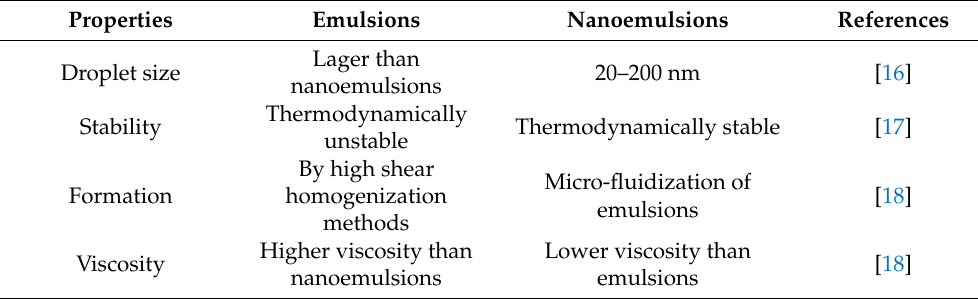
Figure 3. Stabilization of emulsion by using biopolymer stabilizer [5]. Table 2. Differences between emulsion and